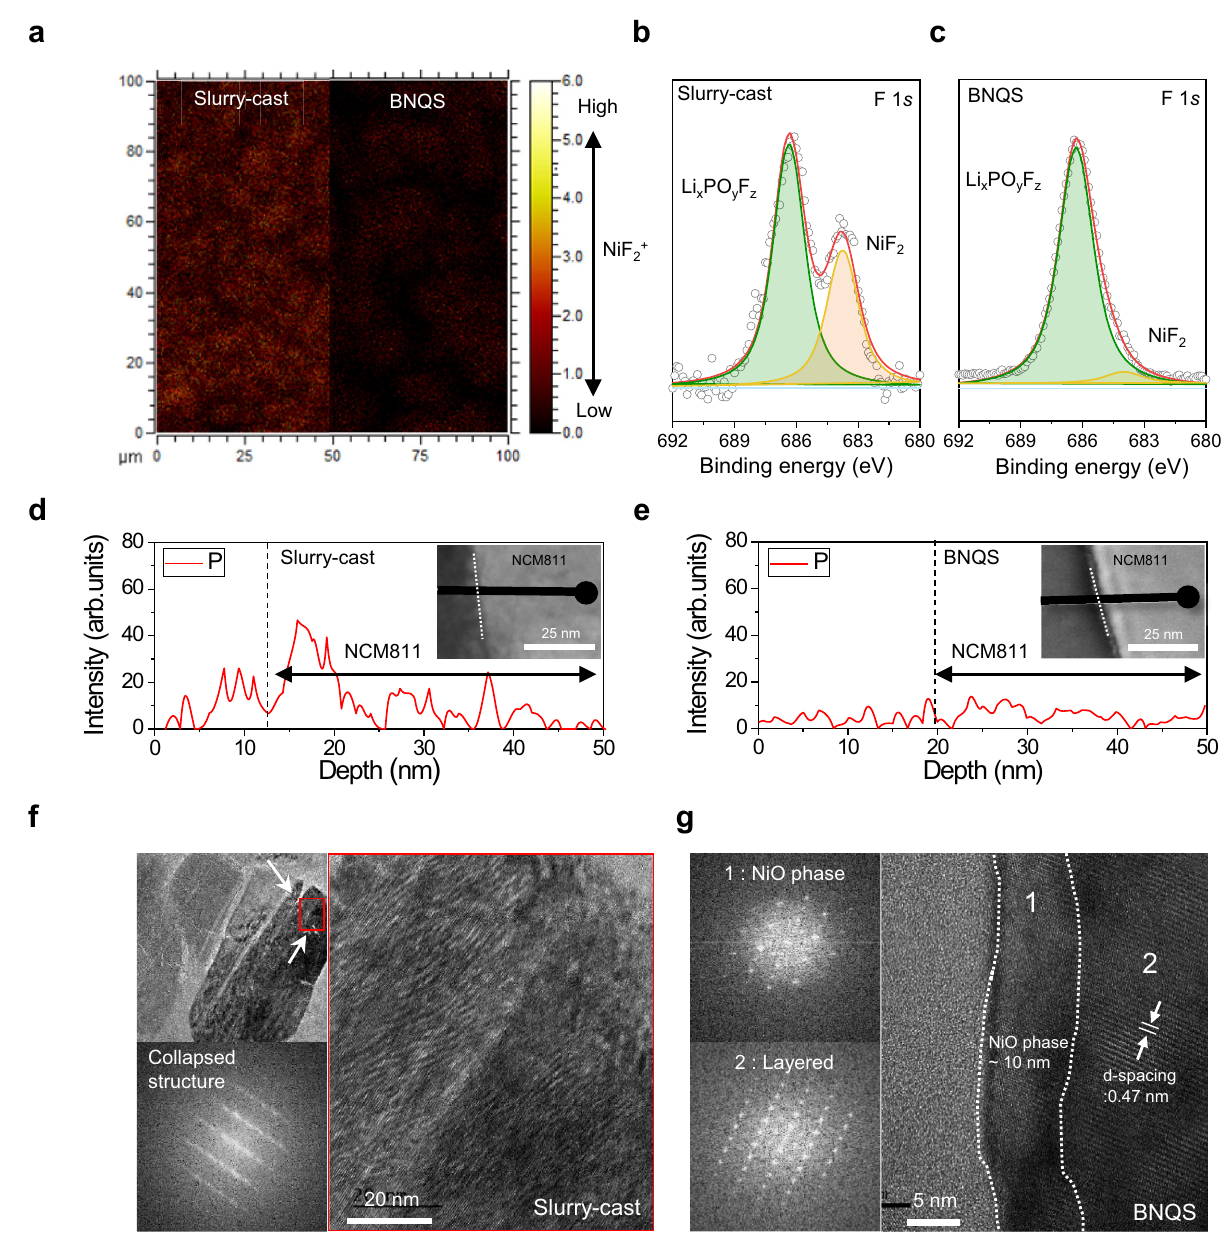
Fig. 5 Post-mortem analysis of the cycled BNQS cathode (versus slurry-cast cathode). a TOF-SIMS mapping images of the NiF 2 + byproducts formed on the surface of the cathodes. XPS F 1 s spectra, focusing on a characteristic peak assigned to NiF 2 (684.6 eV) byproducts of b slurry-cast and c BNQS cathodes. EDS line intensities for P element along the depth of NCM811 particles of d slurry-cast and e BNQS cathodes. HR-TEM images with fast Fourier transform patterns of the NCM811 particles of f slurry-cast and g BNQS